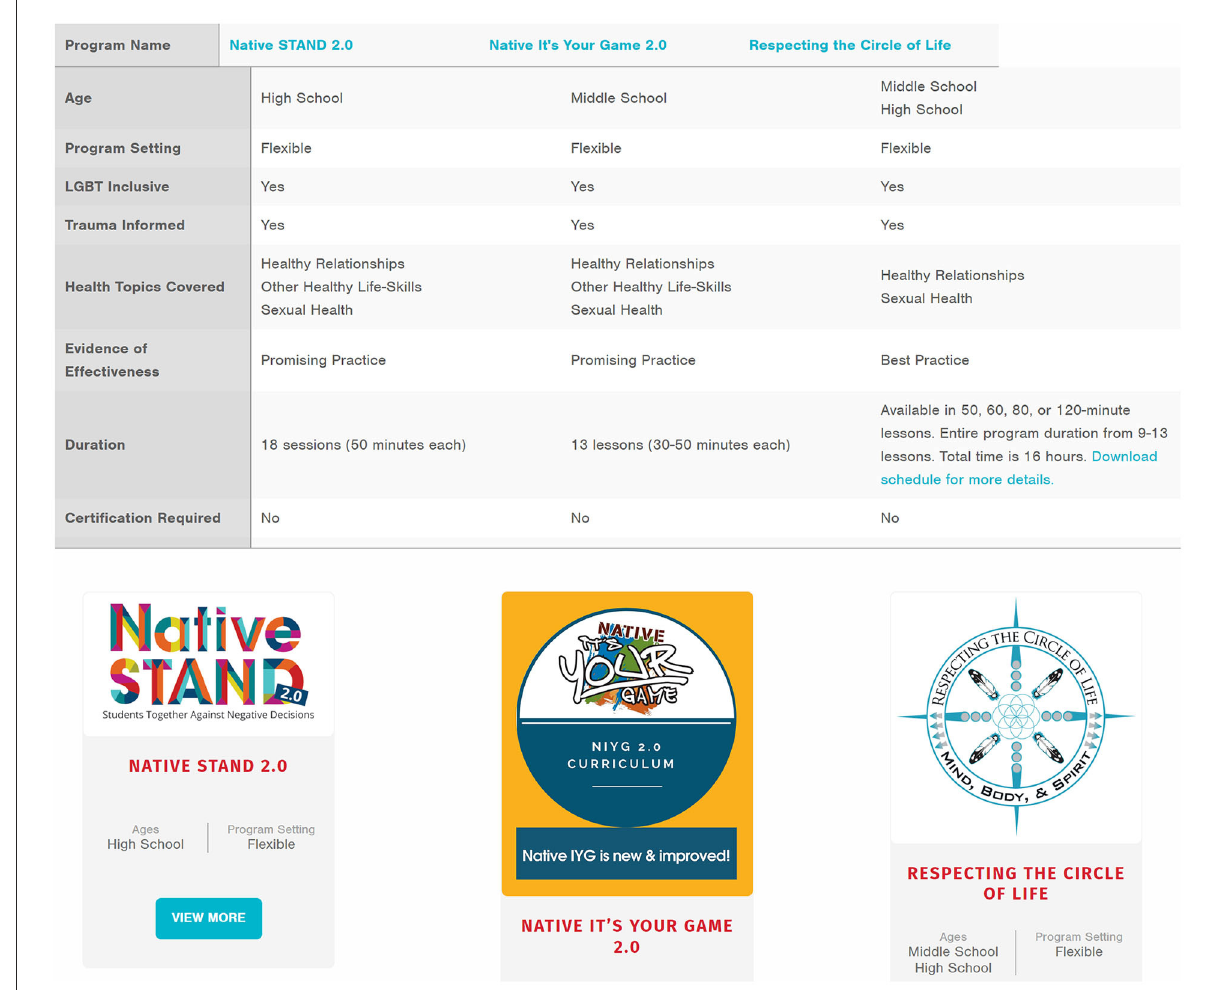
FIGURE9 Healthy Native Youth curriculum portal resources, including curriculum comparison chart and example